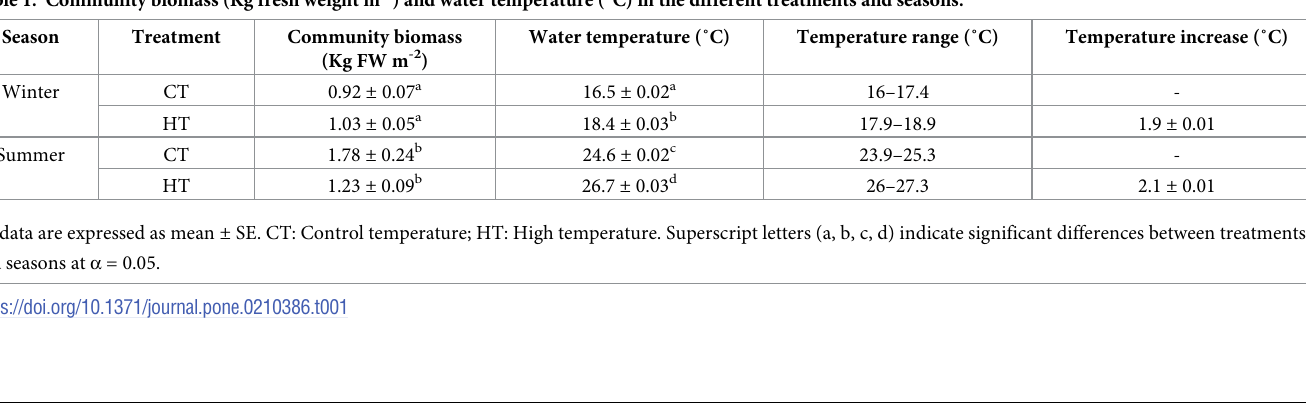
Table 1. Community biomass (Kg fresh weight m -2 ) and water temperature (˚C) in the different treatments and seasons. Season